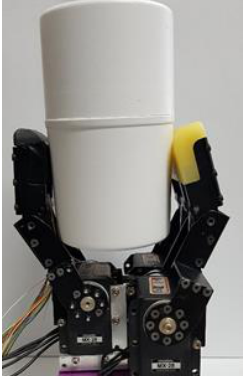
Figure 3. Object weight detection experiment.